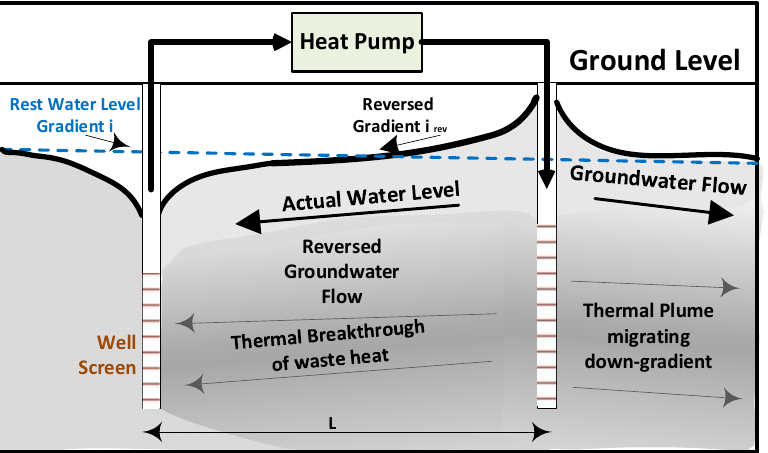
Figure 1. Schematic illustration of a typical shallow geothermal well-doublet system with a single primary loop, no heat exchanger, in an unconfined aquifer (modified from [27]). Specifically, T in is not the original reservoir T o ; it is the temperature at the surface going into the energy system (the heat exchanger between the primary loop and the sec- ondary power/heat system loop). It will eventually change with time as cool injected flu- ids begin to impinge upon the production well. Nor is T out equal to the ambient tempera- ture; T out will always be higher because of thermodynamic constraints. Unextracted heat